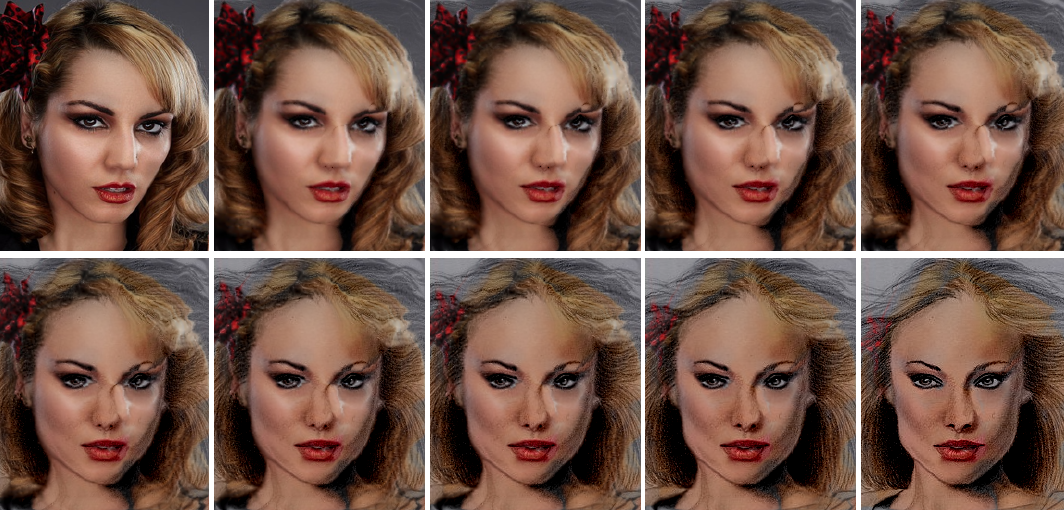
Figure 7. Color transport along the image